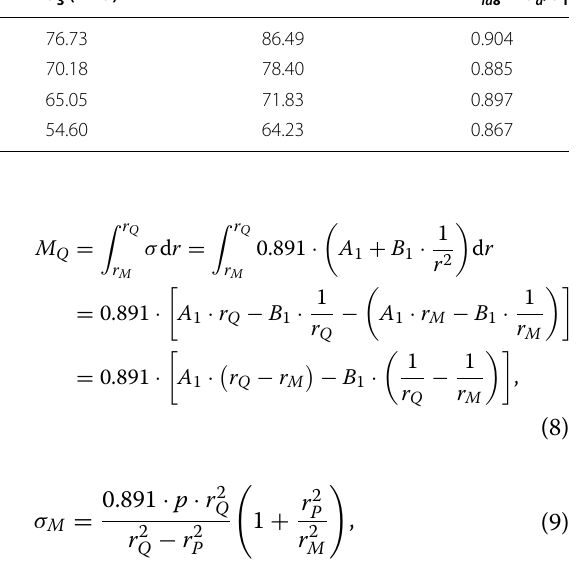
Table 4 Correction factors Y Radius r (mm)